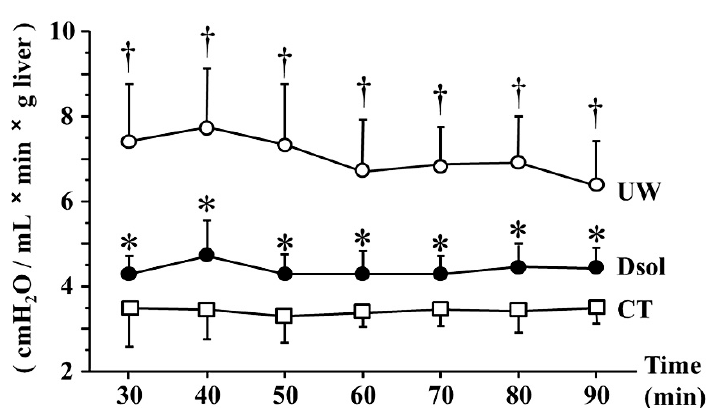
Figure 3. Dsol reduces portal venous resistance (PVR). PVR was the lowest in the CT group ( □ ). It was the highest in the UW group ( ○ ), whereas it was signi fi cantly reduced in the Dsol group ( ● ) throughout the experiment. Data were expressed as the means ± SD ( n = 6). *† A p -Value less than 0.05 was considered significant: *: UW versus Dsol, † versus CT.